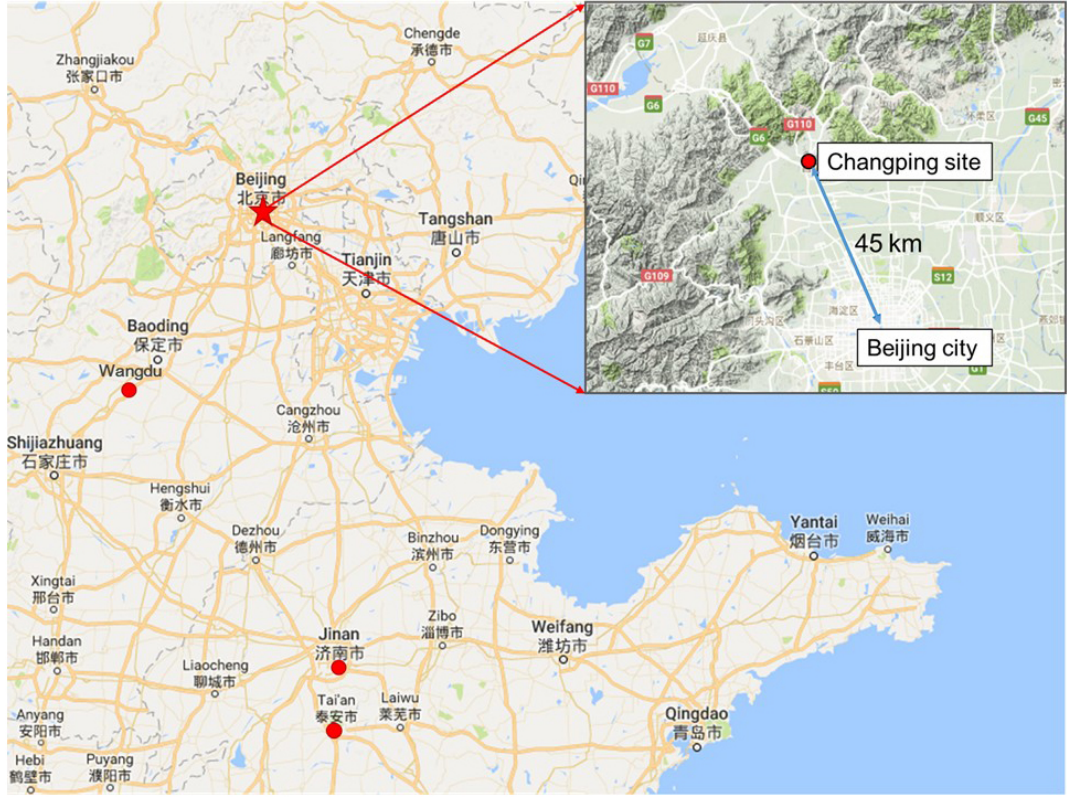
Figure 1. Map of Beijing and the surrounding area. The red star shows the location of the Changping site, and red dots show other sites where previous N 2 O 5 measurements were conducted in the North China Plain (NCP), including Wangdu, Jinan, and Mount Tai